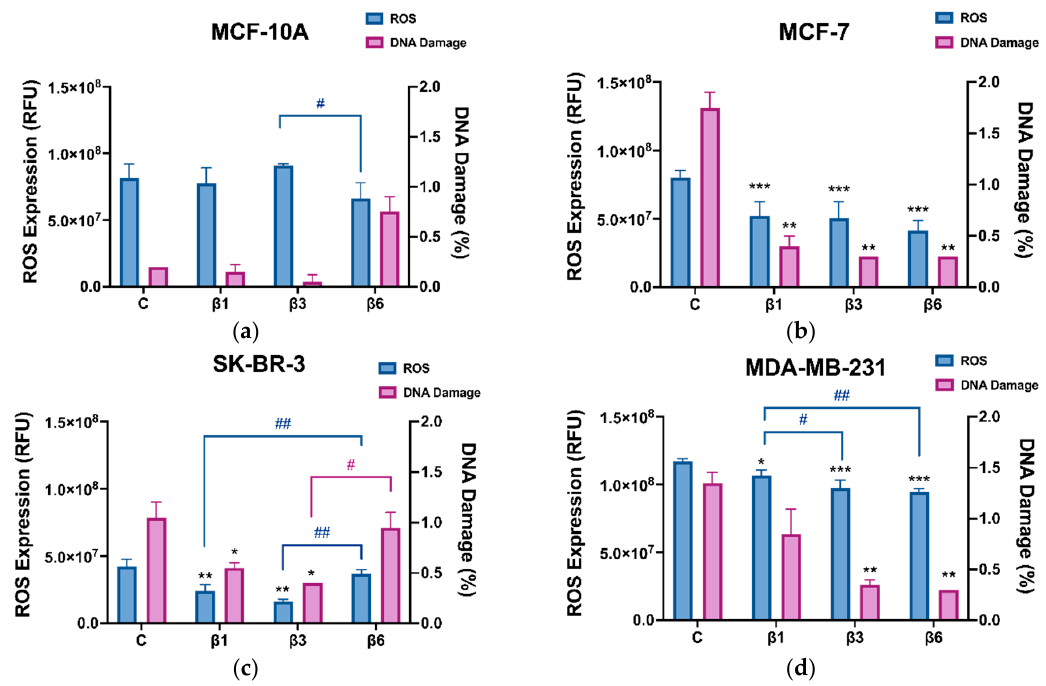
Figure 4. ROS levels and DNA damage percentage after treatment with β 1-conglutin (2.5 ng/µL), β 3-conglutin (5 ng/µL), or β 6-conglutin (10 ng/µL) for 24 h in ( a ) MCF-10A, ( b ) MCF-7, ( c ) SK-BR-3, and ( d ) MDA-MB-321. For intracellular ROS level detection, after 24 h of ( a ) β 1, ( b ) β 3, and ( c ) β 6-conglutin treatment, the culture medium was removed, cells were washed twice with PBS and then incubated with 100 µL of a 10 µM DCFH-DA concentration in serum-free medium for 30 min in the dark. Finally, fl uorescence was measured in a Triad multimode reader using a length of excitation of 485 nm and a length of emission of 525 nm. For DNA damage detection, after 24 h of (a) β 1, ( b ) β 3, and ( c ) β 6-conglutin treatment, cells were trypsinized, fi xed, and permeabilized following the γ H2Ax detection kit BD Cyto fi x/Cytoperm protocol, and fi nally incubated with the PE-CF594 Mouse anti-H2Ax (pS139) antibody (BD Biosciences) for 30 min in the dark. Samples were immedi- ately analyzed using the BD FACS Aria IIIu Flow Cytometer (Becton Dickinson, BD Bioscience). * p < 0.05, ** p < 0.01, and *** p < 0.001 vs. non-treated cells, and # p < 0.05, ## p < 0.01 vs. other treatments. 3.3. Implication of SIRT1/FoxO1 Pathway in β -Conglutins E ff ect on In Vitro Cultured Breast Cancer Cells In order to elucidate the potential mechanism of action of the β -conglutins, we ana- lyzed changes in SIRT1 expression, implicated in BC growth and progression [26] that is sensible to cellular stress induced by ROS [36–38] acting through the activation of FoxO1